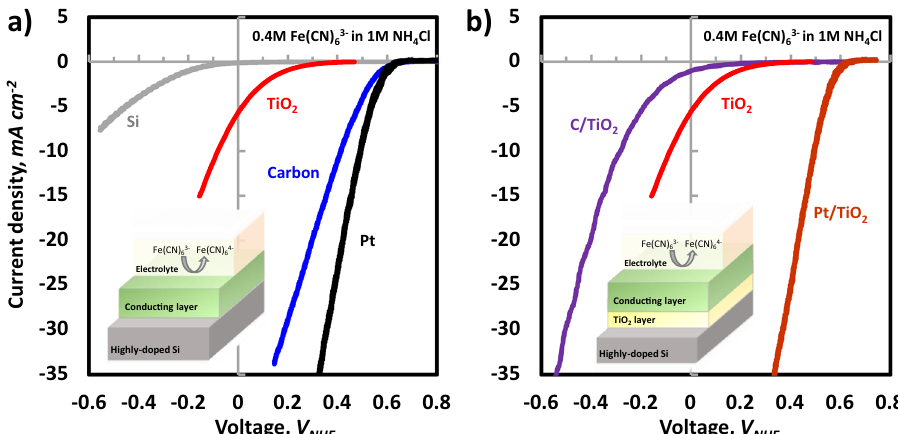
Fig. 1 Electrochemical LSV results for various conducting layers. Conducting materials deposited directly on the degenerately doped Si ( a ) and samples with TiO 2 interlayer deposited on the same substrate ( b ). Both measurements were conducted in 0.4 M Fe(CN) 6 3 − , with 1 M NH 4 Cl supporting electrolyte at pH 7 (adjusted by using NH